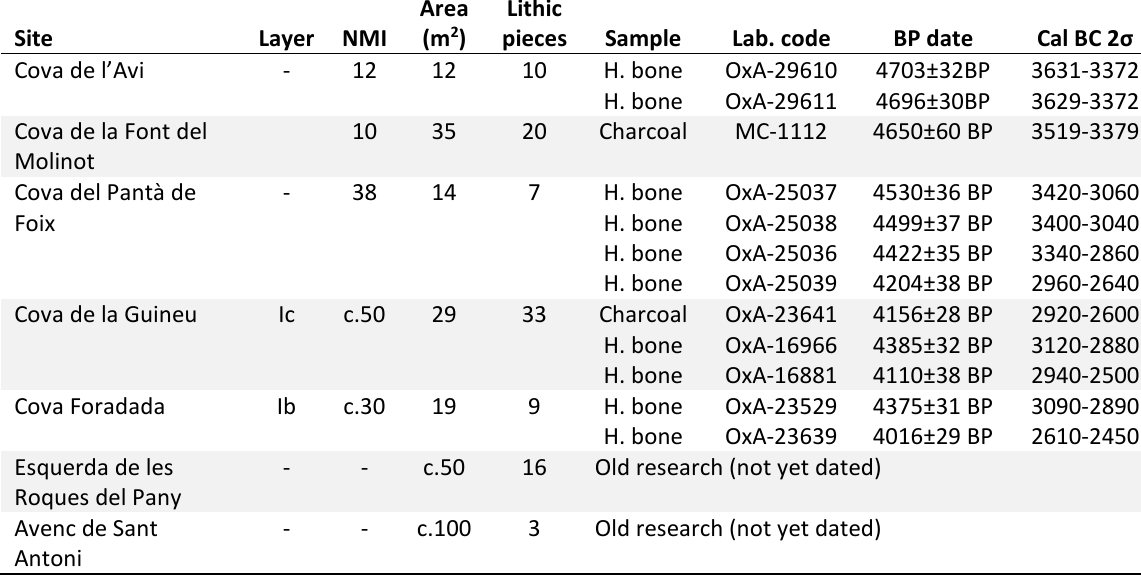
Area Lithic (m 2 ) pieces Sample Lab. code BP date Cal BC 2 σ